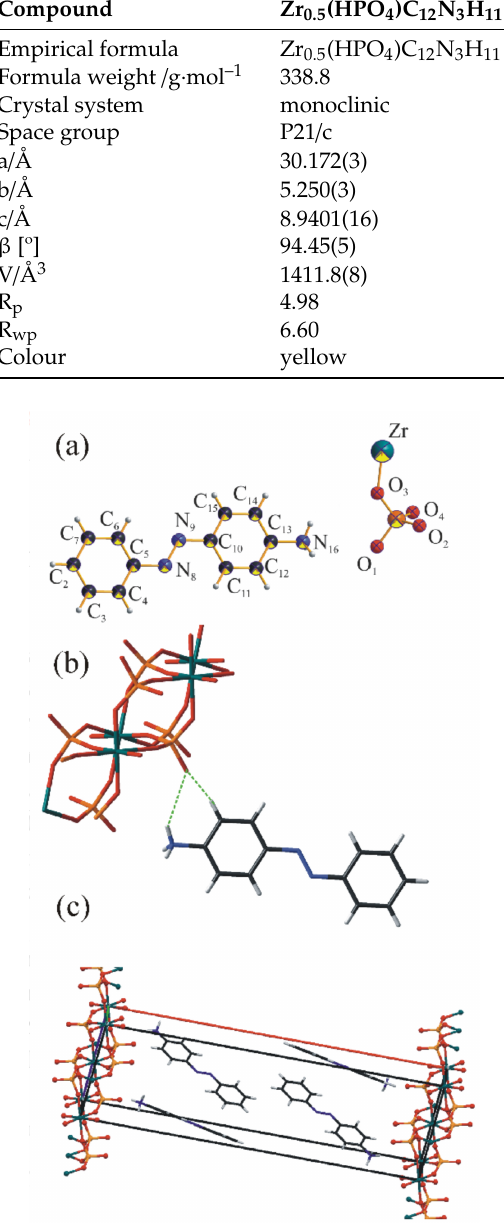
Figure 6. ( a ) The asymmetric unit of ZpA, ( b ) the hydrogen bonds in ZpA sample, ( c ) the oblique arrangement of pAz molecules in the ZrP